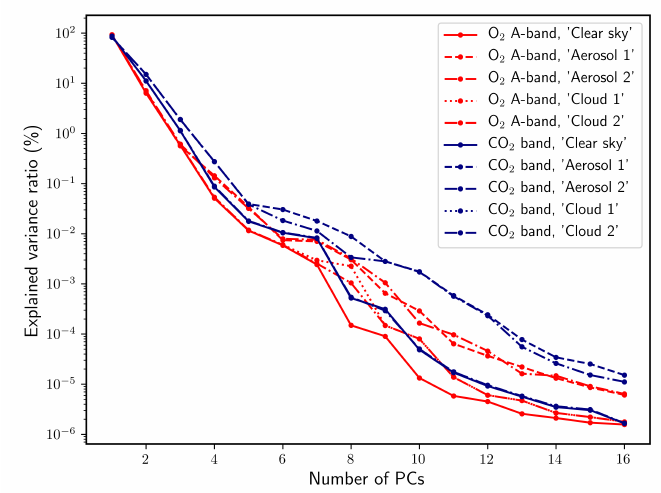
Figure 7. Explained variance ratio in percentage as a function of the number of PCs for all the atmospheric scenarios: ‘Clear sky’, ‘Aerosol 1’, ‘Aerosol 2’, ‘Cloud 1’ and ‘Cloud 2’; and the two spectral bands (O 2 A- and CO 2 bands). The red color corresponds to the O 2 A-band and the blue color to the CO 2 weak band. The different dashing of the lines indicates the different atmospheric scenarios. To select the number of clusters and regression points for the CLSR method, we estimate the mean error (cf. Equation (9)). As an example, we illustrate in Figure 8 the mean errors for the ‘Aerosol 2’ scenario. The results show that 4–5 clusters and 3–5 regression points guarantee a small mean error.